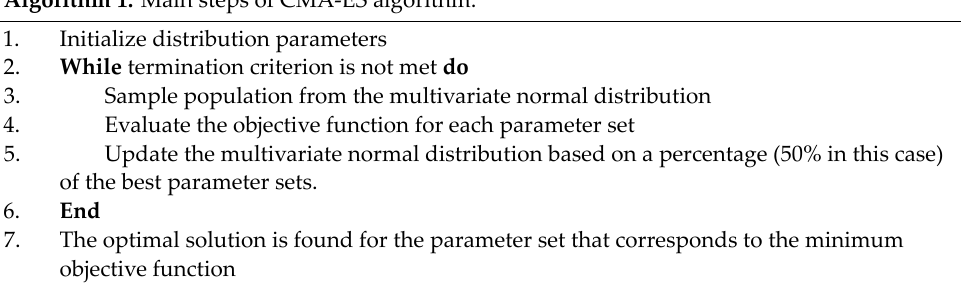
Algorithm 1. Main steps of CMA‑ES